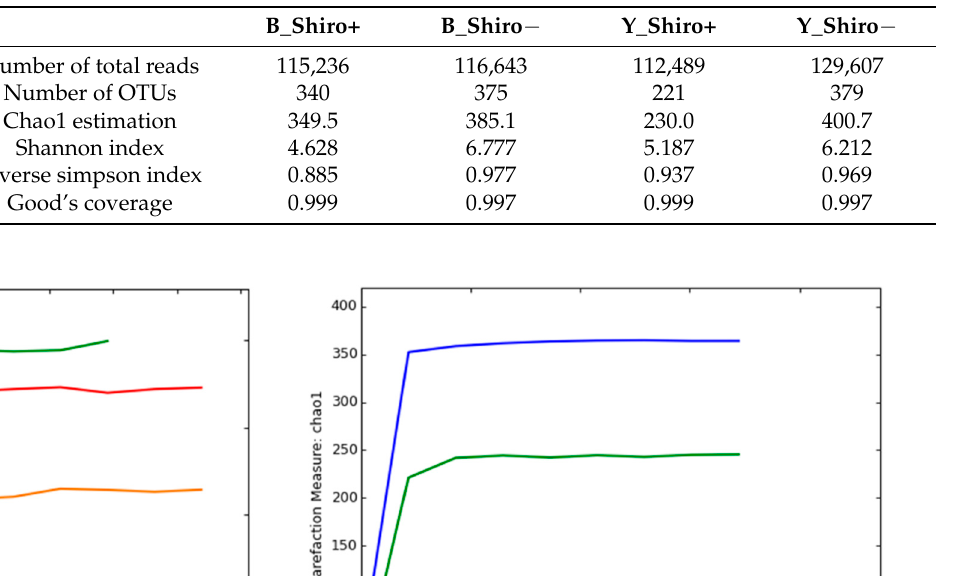
Table 2. Summary of Illumina sequencing and statistical analysis of bacterial communities inhabiting the Tricholoma matsutake production (shiro+) and nonproduction (shiro − ) soils of Bonghwa (B) and Yangyang (Y) sampling sites.